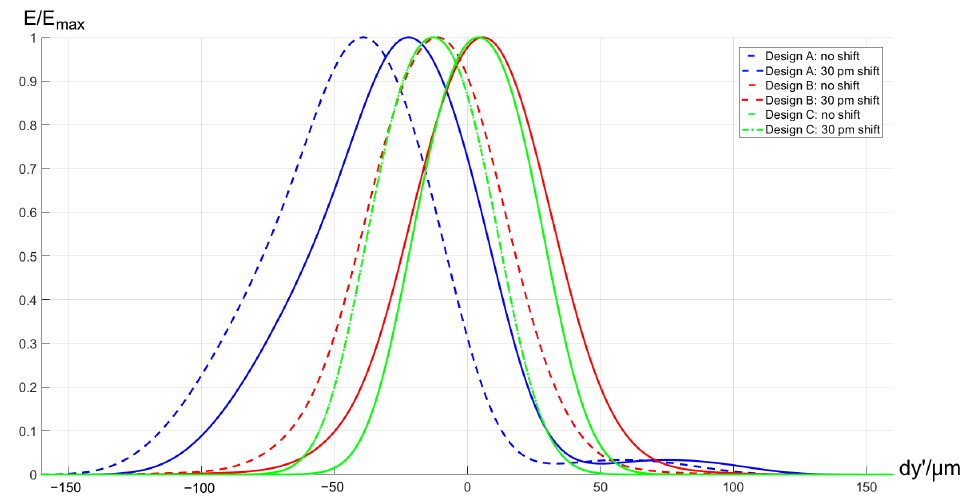
Figure 14. Simulation of fiber Bragg grating (FBG) profiles obtained with different